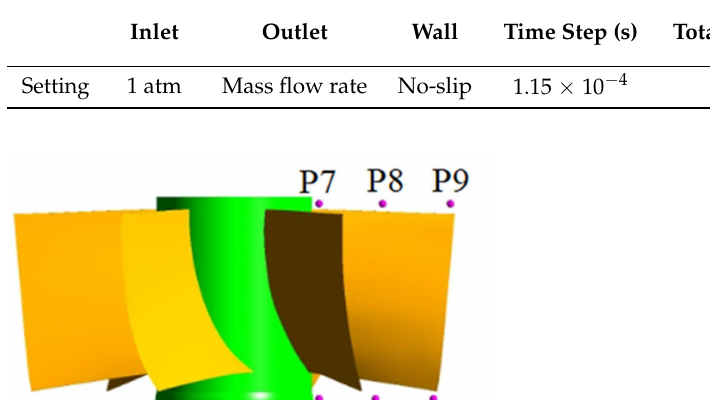
Table 2. The boundary conditions and calculation settings.